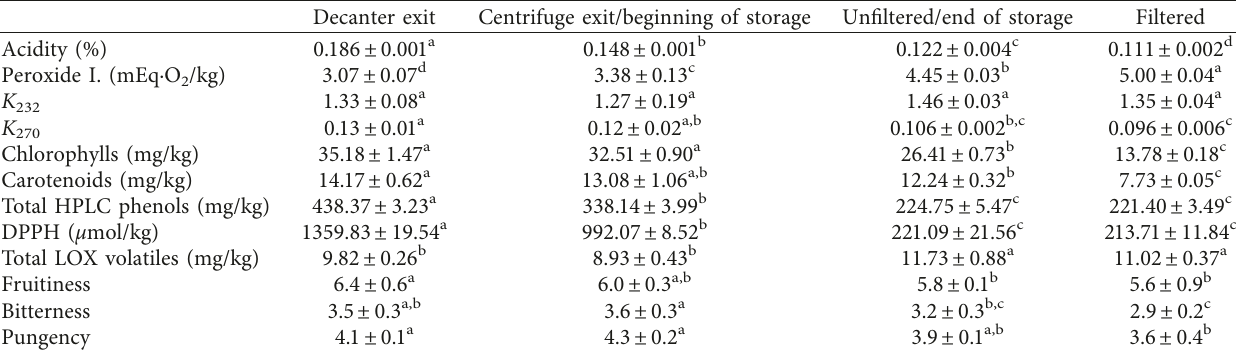
Table 1: Quality parameters and sensory characteristics for the oil samples before and after vertical centrifugation, storage, and filtration ∗ .